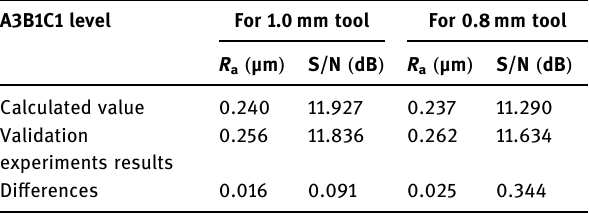
Table 10: Validation experiments A3B1C1 level For 1.0 mm tool For 0.8 mm